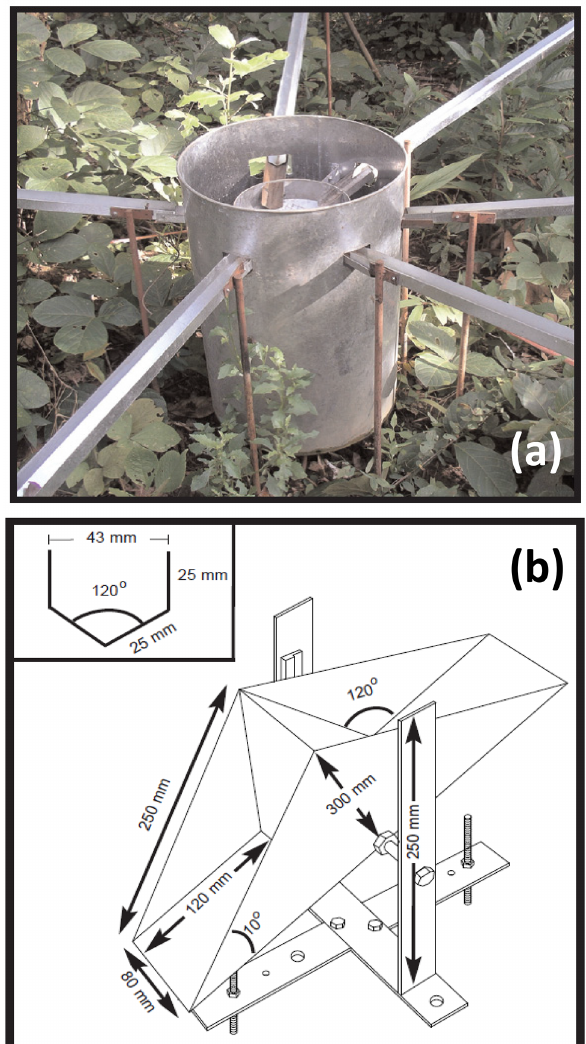
Figure 2. (a) Stationary collector with six collection troughs (gut- ters). (b) Schematic of stationary gauge tipping-bucket mechanism (located inside the collector base); the inset shows the dimensions for the collection troughs